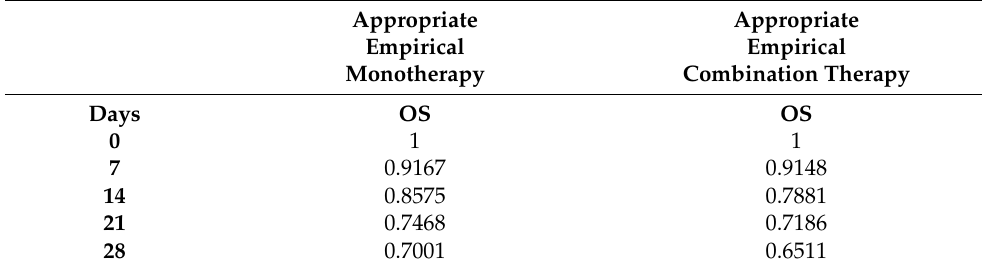
Table 2. Log-rank test for equality of survivor functions, p -value = 0.7694.